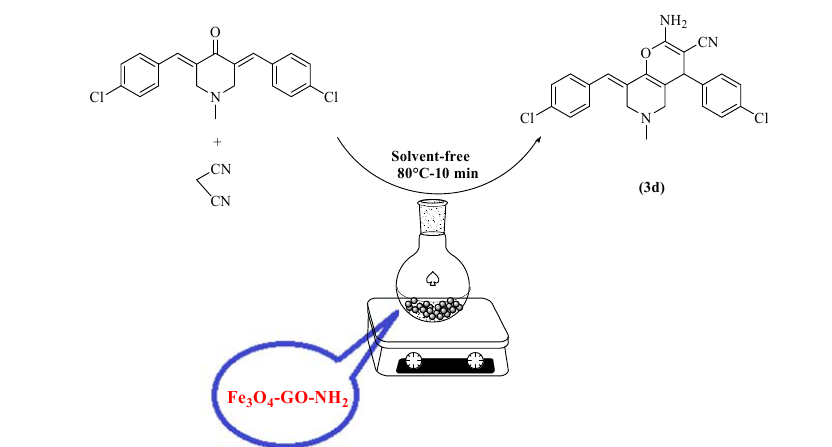
Fig. 4. The EDX spectra of Fe Figure 4. The EDX spectra of Fe 3 O 4 -GO-NH 2 . Figure 4. The EDX spectra of Fe 3 O 4 -GO-NH 2 .